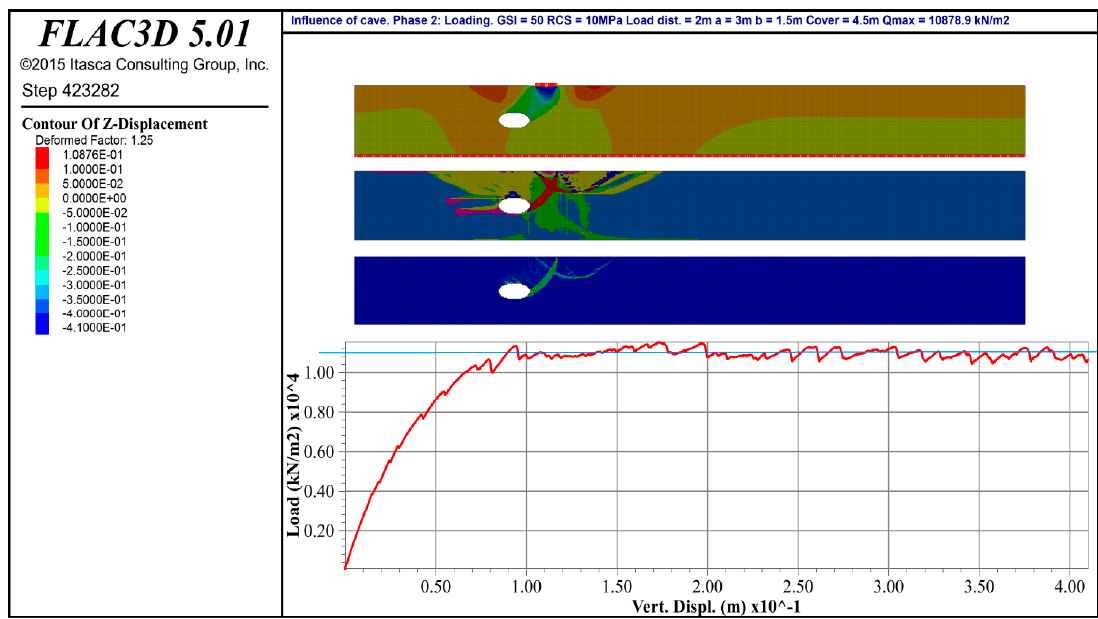
Figure 3. CaseIEH-2. Eccentricity E/a = 1 ( punching shear failure mechanism with nearly vertical cut surfaces).